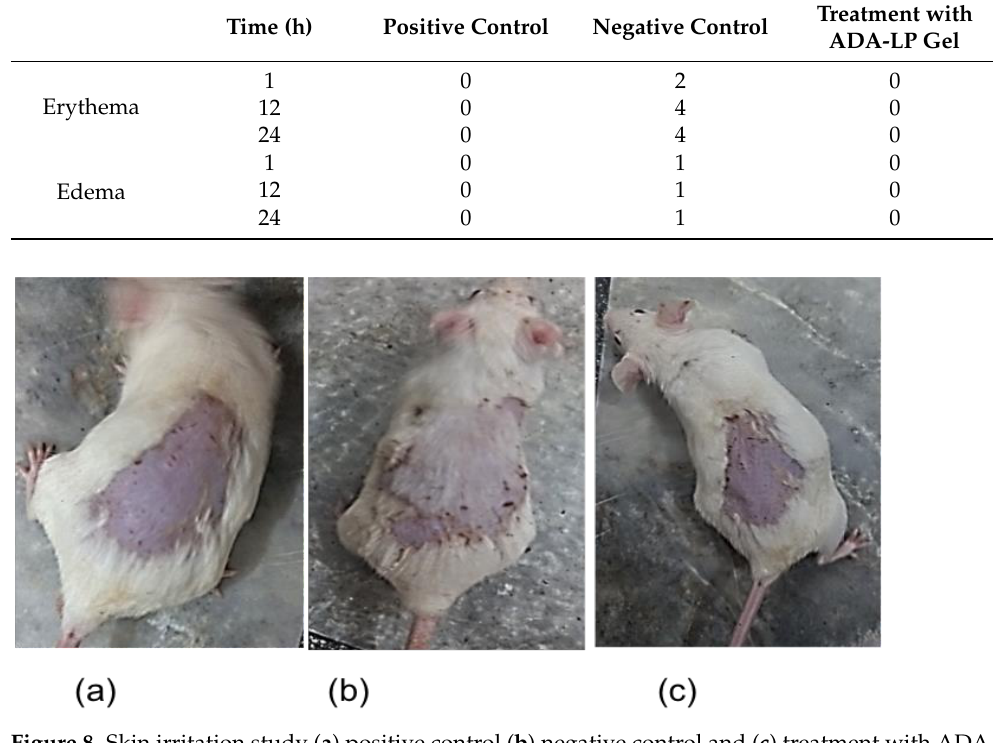
Figure 8. Skin irritation study ( a ) positive control ( b ) negative control and ( c ) treatment with ADA- LP gel. LP gel. Table 4. Skin irritation study according to Draize scoring system.